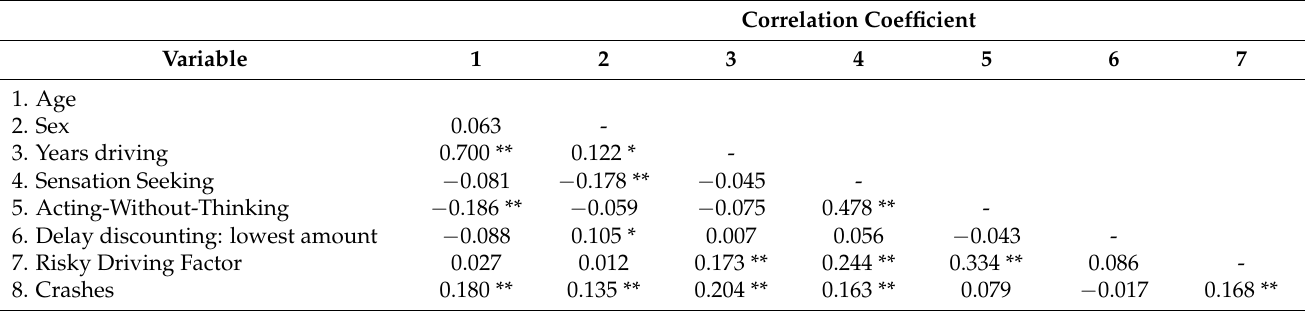
Table 4. Table of Pearson’s correlation coefficients between variables.